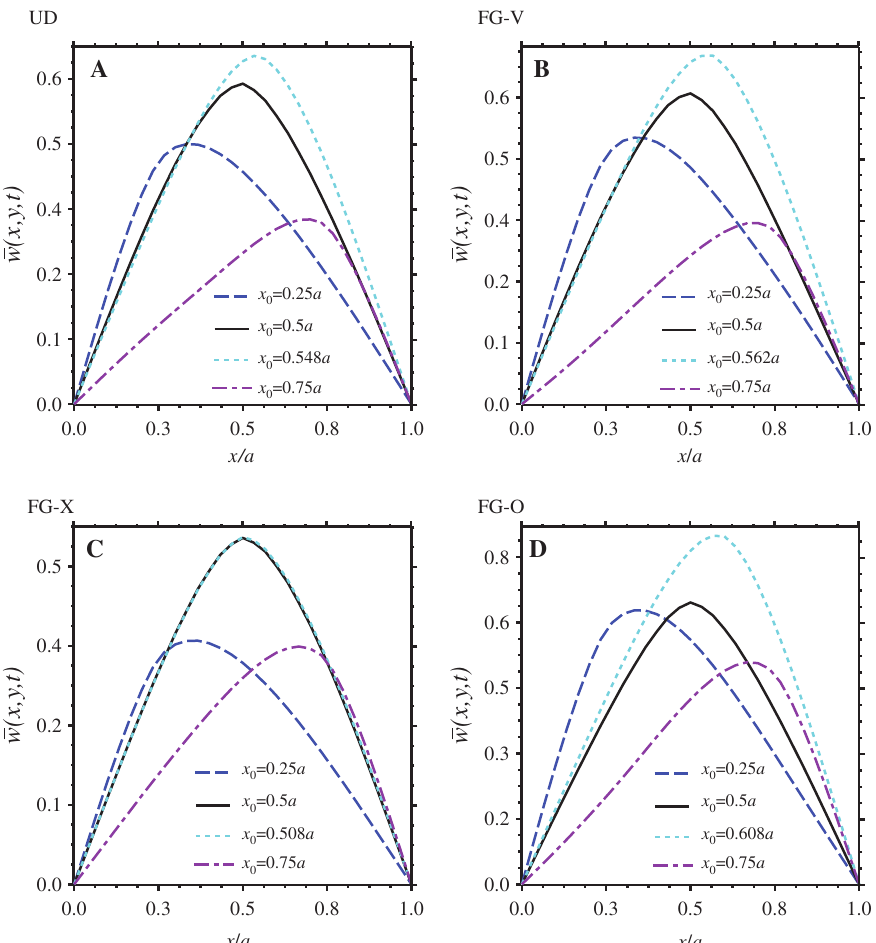
Figure 12 (A)–(D) The influence of the load location on the profile of the material line y = b /2 for the simply supported square CNTRC plate = 5 ( v 0